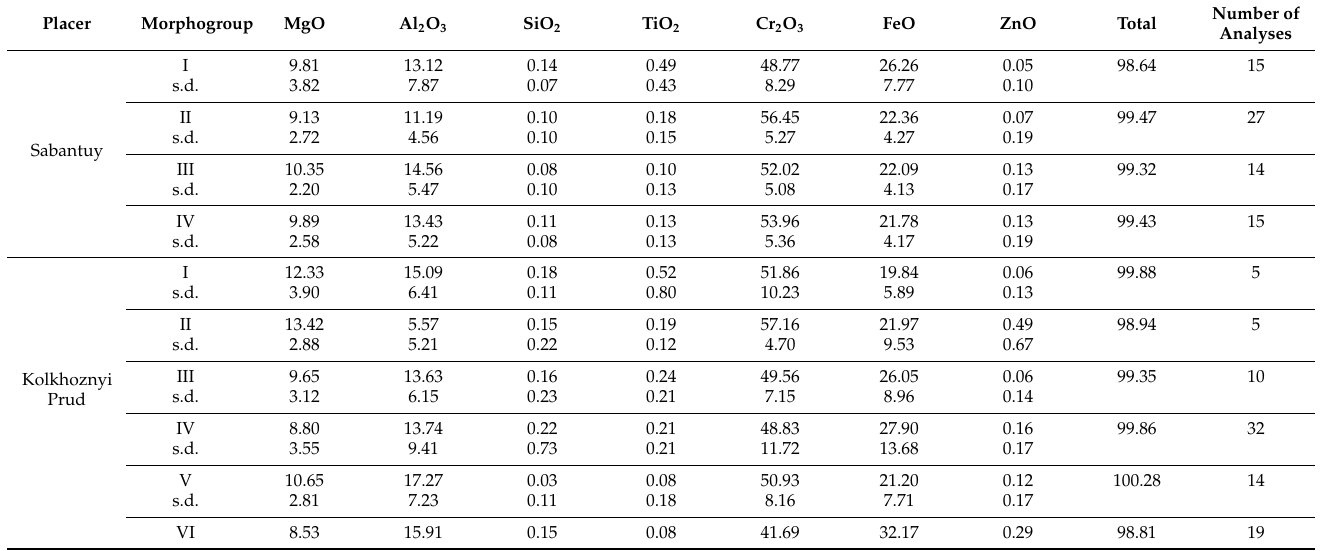
Table 2. Average chemical composition of chromian spinels from different morphogroups in all studied placers.